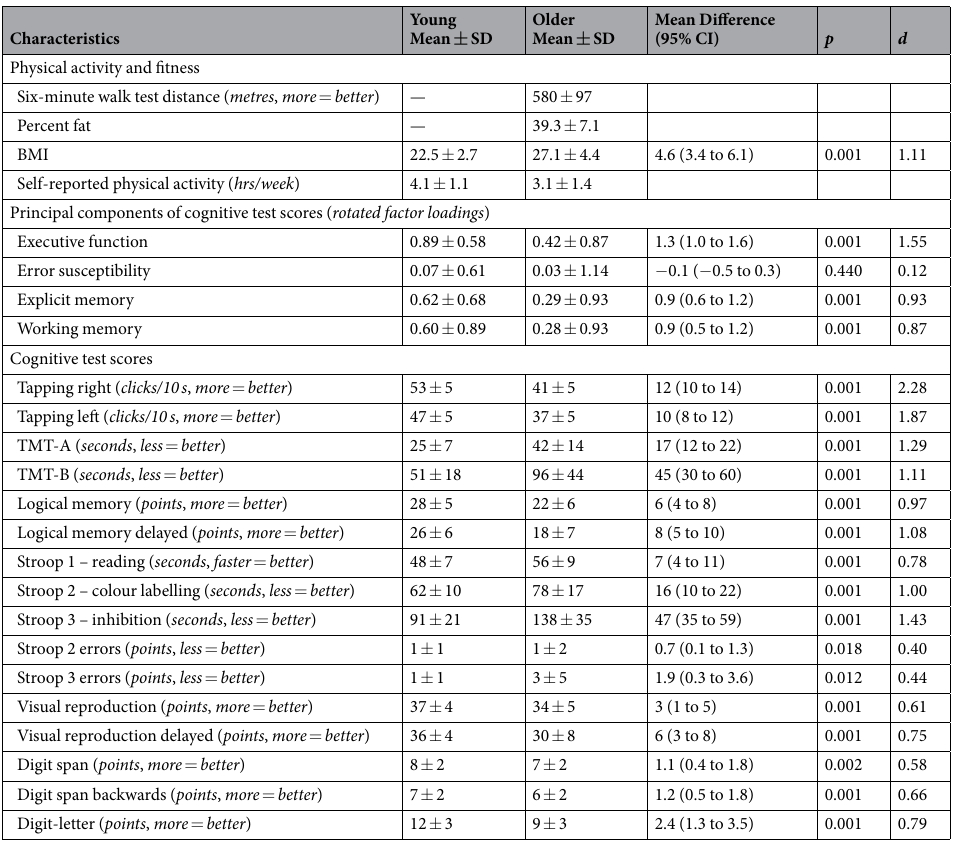
Table 5. Sample characteristics. Difference between the age groups was tested using independent samples t - tests (two-tailed, bootstrap statistics). SD, standard deviation. P , statistical significance; d , Cohen’s d